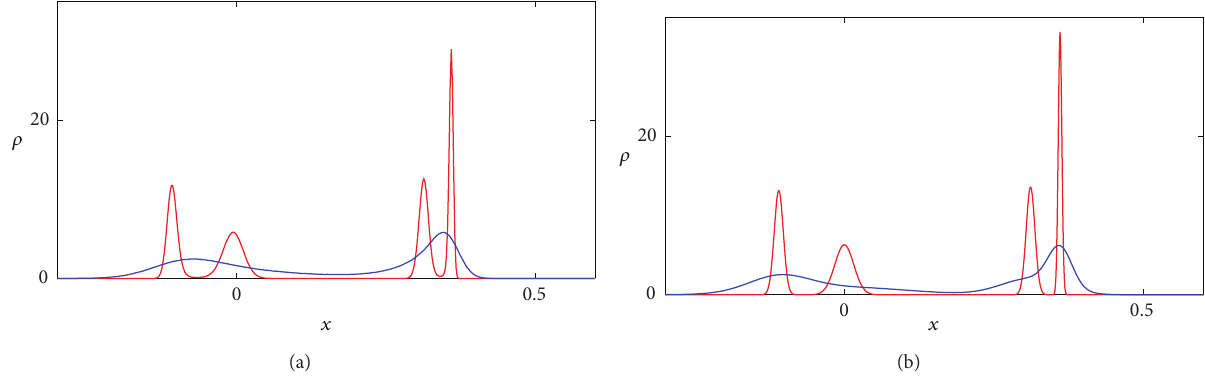
Figure 6: Backward stochastic bifurcation for 𝛾 = −3.74 . Probability density functions for 𝜀 = 0.003 (red) and 𝜀 = 0.02 (blue).